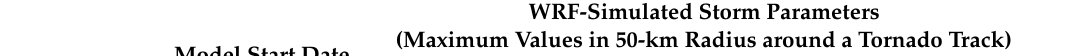
Table 5. Characteristics of the severe storms with tornadoes 3 June 2017 and 18 June 2017, simulated by the WRF model with the 24- and 36-h forecast lead time.